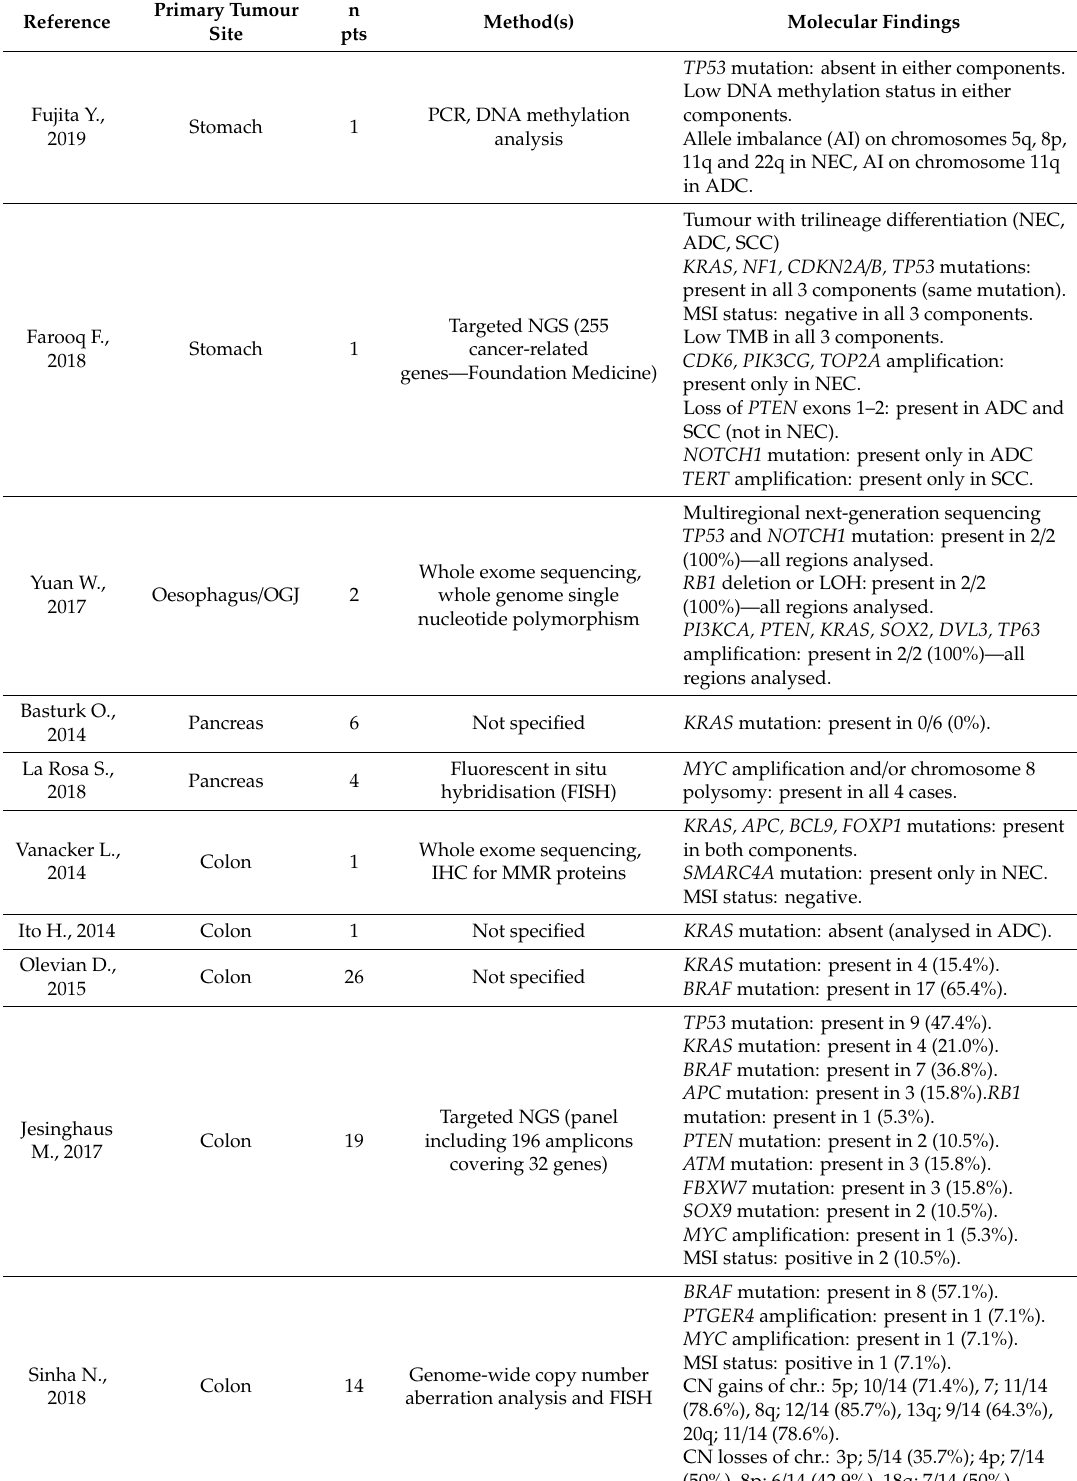
Table 4. Molecular data on patients with mixed neuroendocrine non-neuroendocrine